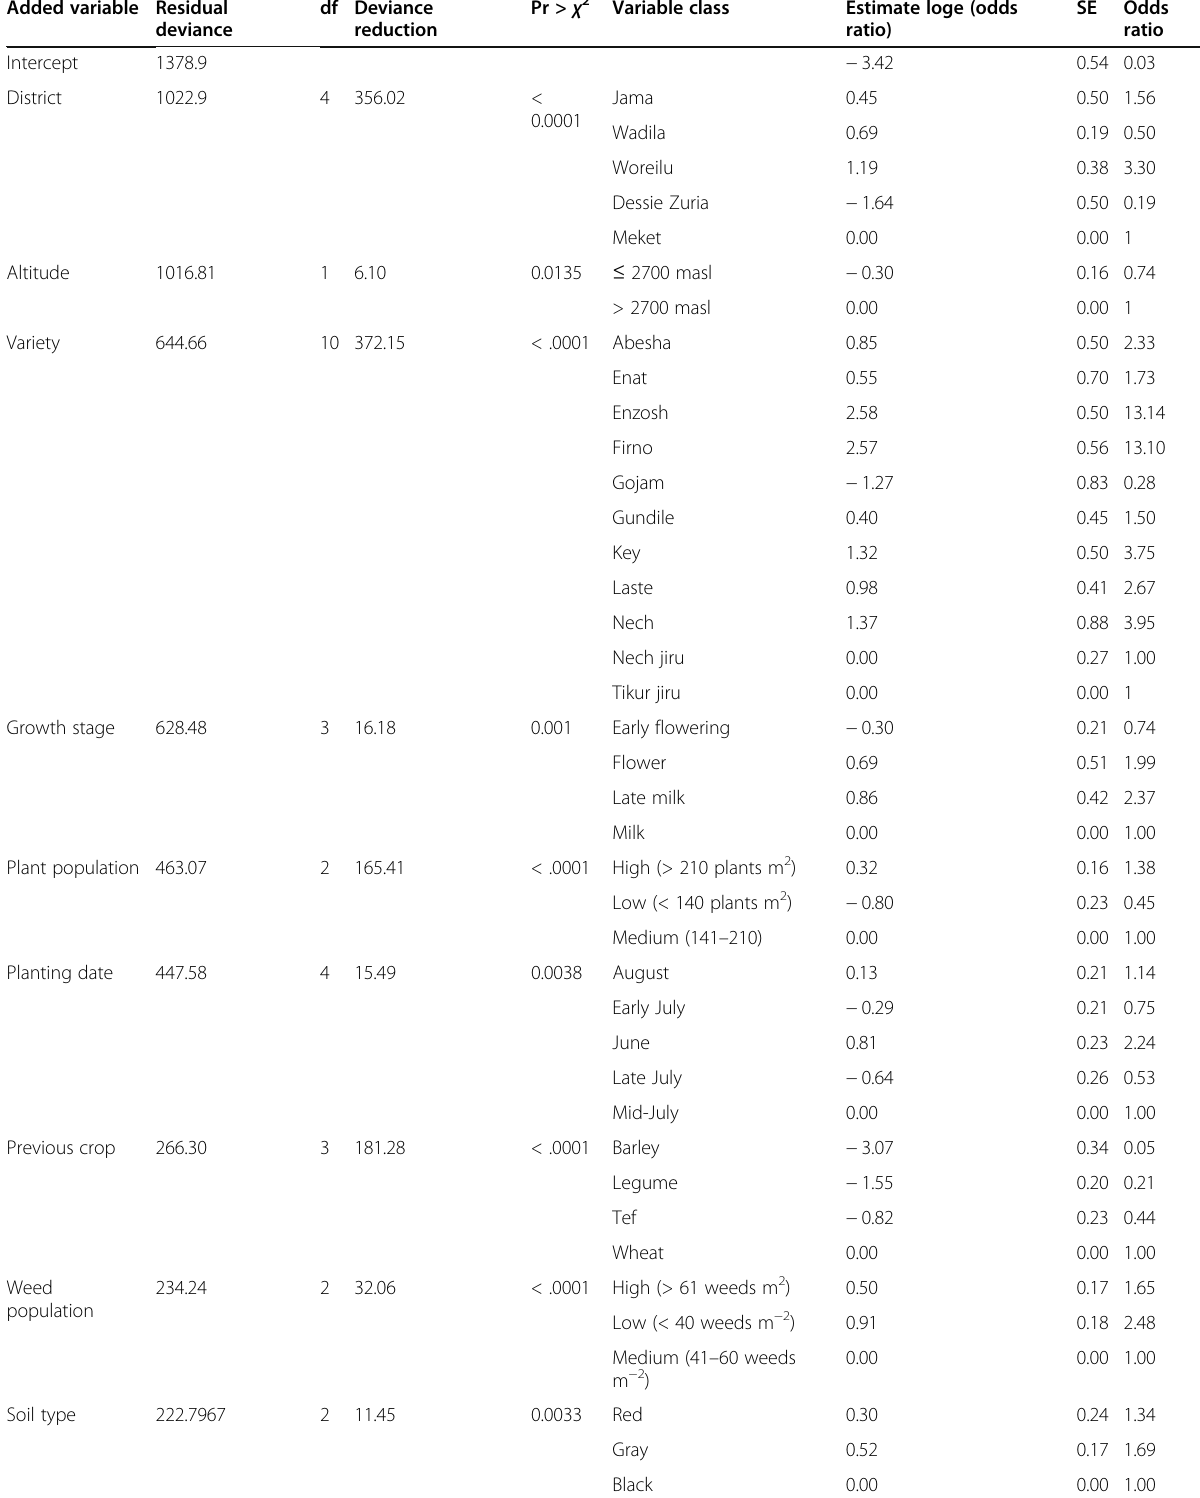
Table 5 Analysis of deviance, natural logarithms of odds ratio, and standard error of added variables in a reduced model analyzing septoria tritici blotch